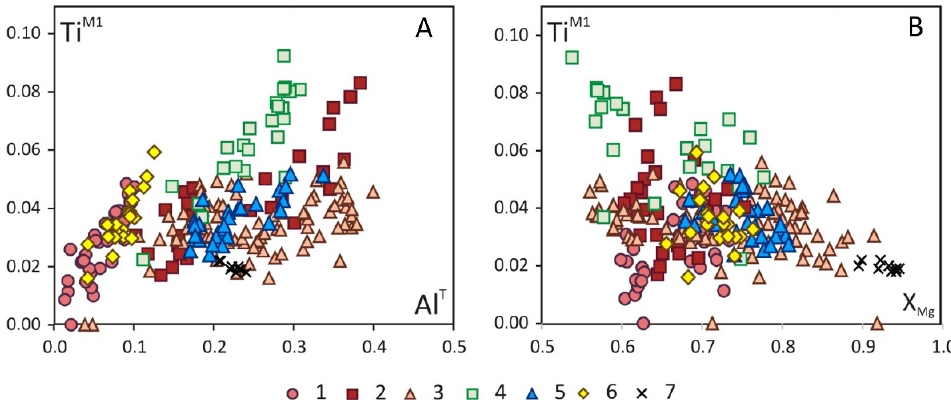
Figure 10. Pyroxene from pyroxenite in binary diagrams. 1–3 = pyroxenes from a pyroxenite fragment with remnant dolerite: dolerite (1), pyroxenite (2), garnet-bearing pyroxenite (3); 4–6 = pyroxenes from other pyroxenite fragments: pyroxenite (4), garnet-bearing pyroxenite (5), biotite-bearing pyroxenite (6); 7 = pyroxenes from the experiments of Mollo et al. [30]. ( A ) Ti M1 –Al T ; ( B ) Ti M1 –X Mg . Nepheline in pyroxenite and nepheline-fassaite samples occurs as isolated fine grains in interstices between fassaites and coarse (up to 1 cm) oikocrysts that enclose small fassaite grains. Such oikocrysts look like phenocrysts but appear as aggregates of finer anhedral grains in polarized-light images (Figure 7E,F). Dolerite-hosted nepheline occurs as fine aggregates with bitownite and spinel in the cores of relatively large plagioclase (labradorite) crystals (Figure 7A,B). Garnet-bearing rocks contain nepheline-clinopyroxene symplectites (Figure 12A). The percentage of kalsilite end-member (Ks) is most often between 15% and 20%, or sometimes 10–12% (Supplementary Table S3). Most of the analyzed nepheline grains contain 1–2 wt.%